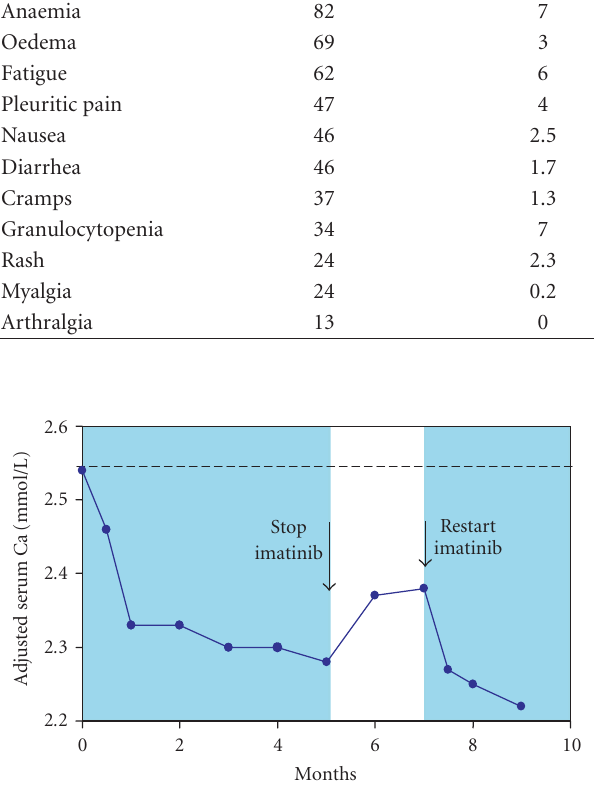
Figure 1: Changes in adjusted serum calcium in the index pa- tient from the start of imatinib treatment. Reference range 2.2– 2.55 mmol/L.